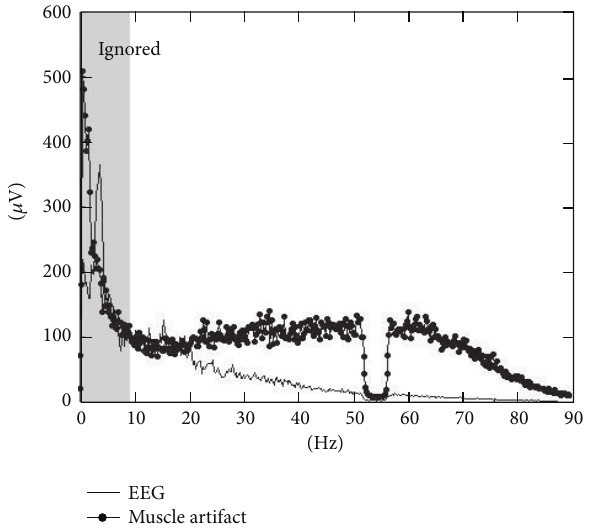
Figure 4: Smoothed Fourier transform module for the two training signals.